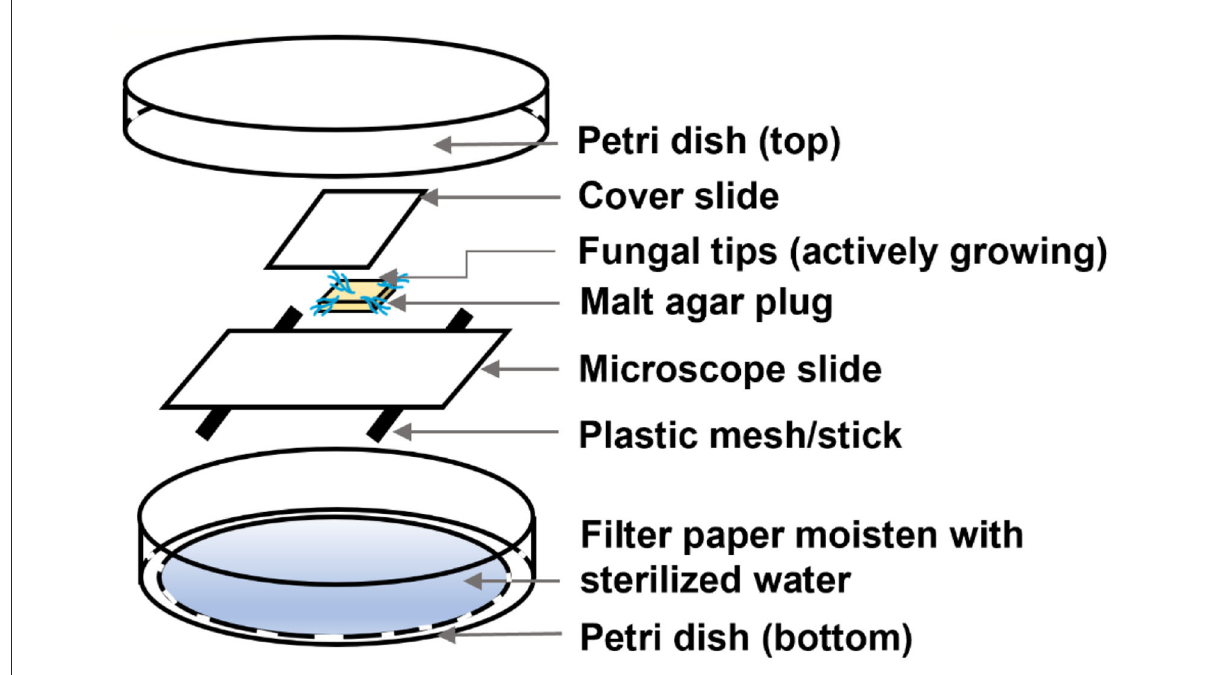
FIGURE1 Expanded view of the fungal slide culture for microscopic